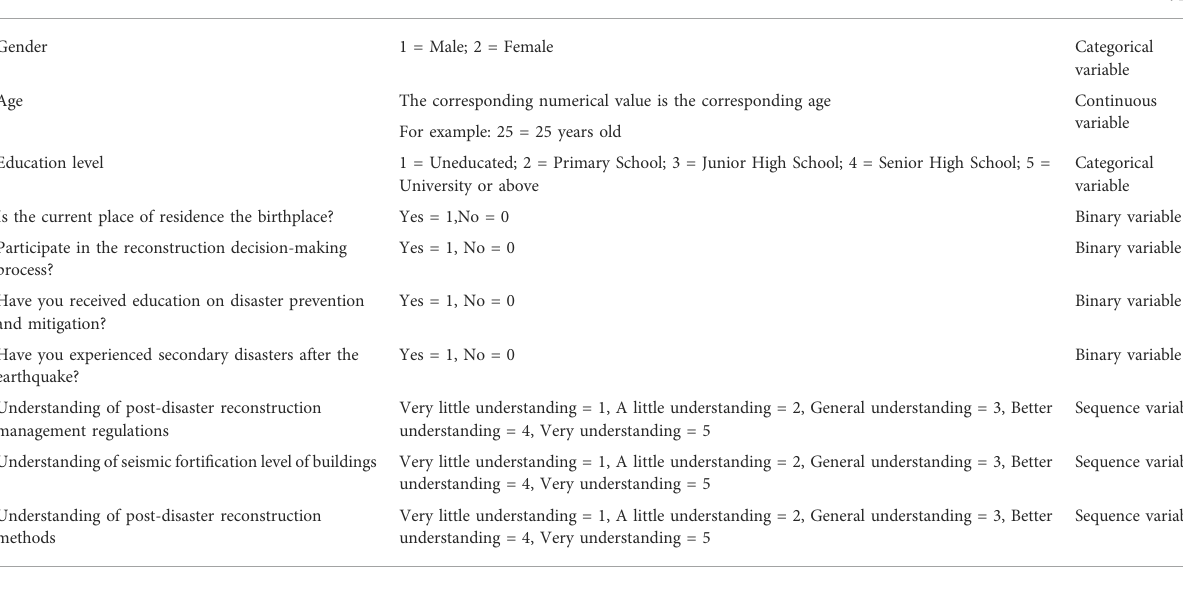
TABLE 1 Description of basic personal information of respondents.